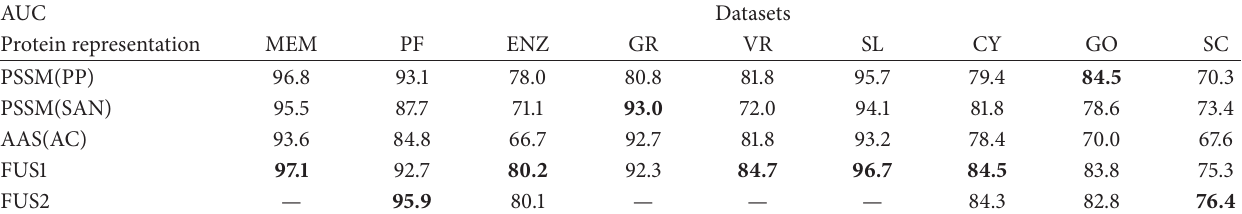
Table 7: Comparison among ensembles and best stand-alone descriptors in terms of AUC in 2 class problems. AUC Datasets Protein representation PSSM(PP)